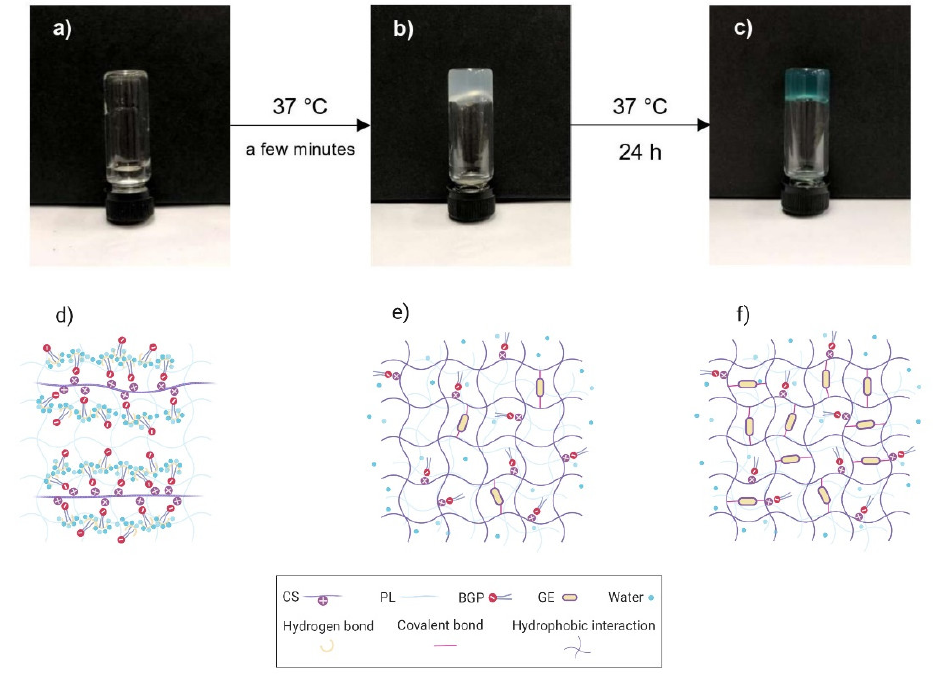
Figure 1. Schematic illustration of the sol-to-gel transition of chitosan (CS)/pullulan (PL)/β-glycerophosphate (BGP)/genipin (GE) hydrogels. The freshly prepared solution ( a , d ), physically crosslinked hydrogels ( b , e ), and co-crosslinked hydrogels ( c , f ).